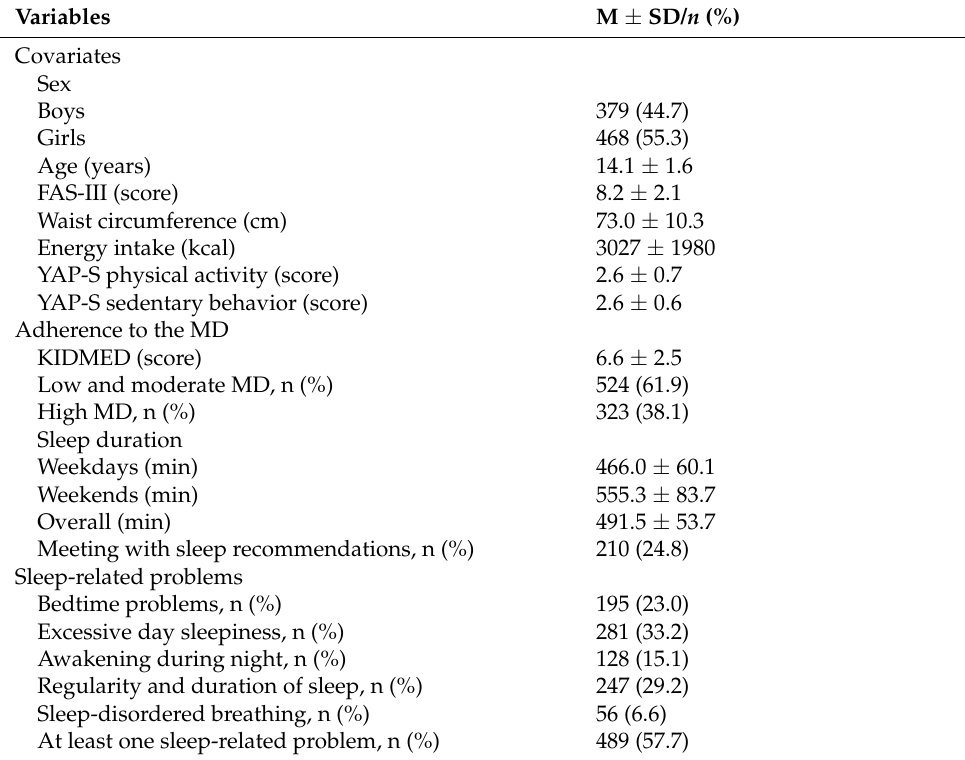
Table 1. Characteristics of the study